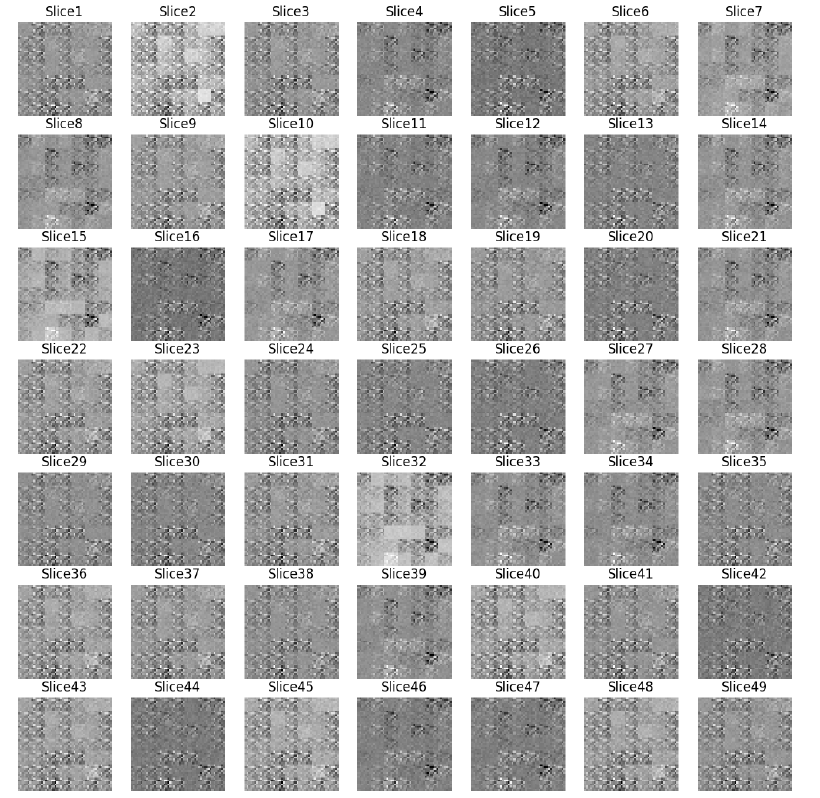
Figure 9. Core tensor filters learned from shifted random